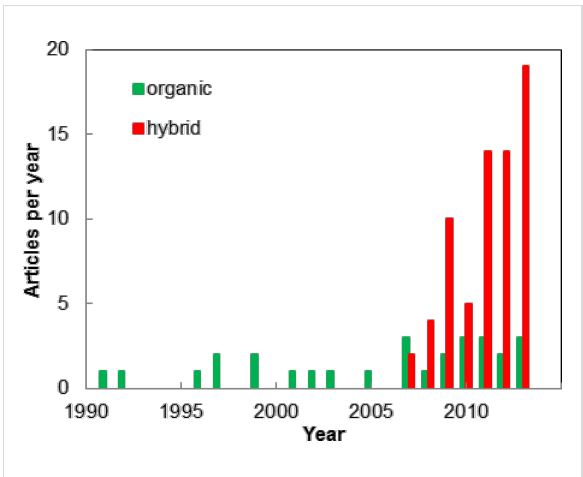
Figure 1: Number of articles annually published featuring organic and hybrid inorganic–organic thin films deposited by MLD and ALD/MLD.